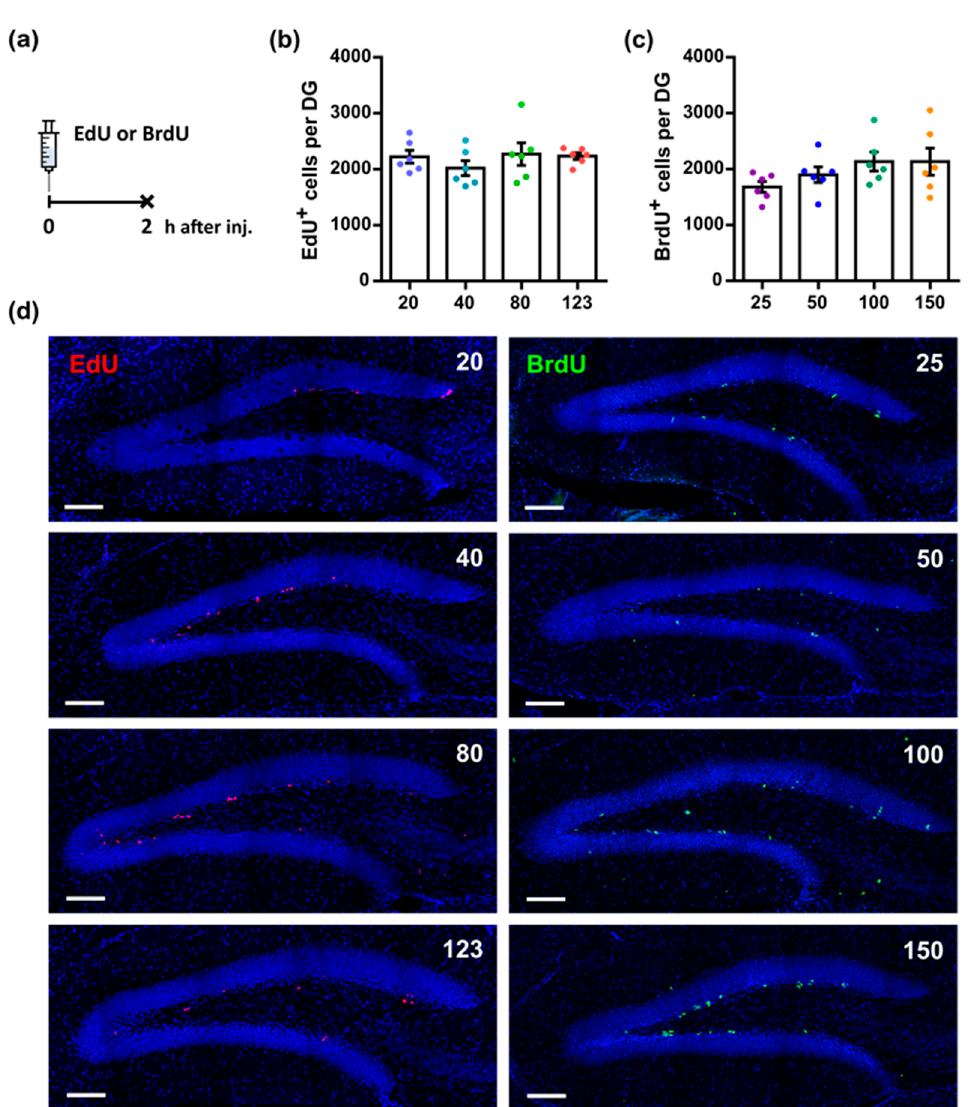
Figure 1. Different doses of thymidine analogs result in equivalent numbers of labeled cells in the SGZ of the DG. ( a ) Scheme of injections; EdU or BrdU at different doses (EdU: 20, 40, 80, or 123 mg/kg; BrdU: 25, 50, 100, or 150 mg/kg) were injected 2 h before euthanasia. ( b ) The number of EdU + cells in the SGZ. ( c ) Number of BrdU + cells in the SGZ. One-way ANOVA did not reveal a significant difference between groups (not marked). ( d ) Representative images of EdU- and BrdU-labeled cells in the sections of the DG; doses are indicated; bar is 100 µ